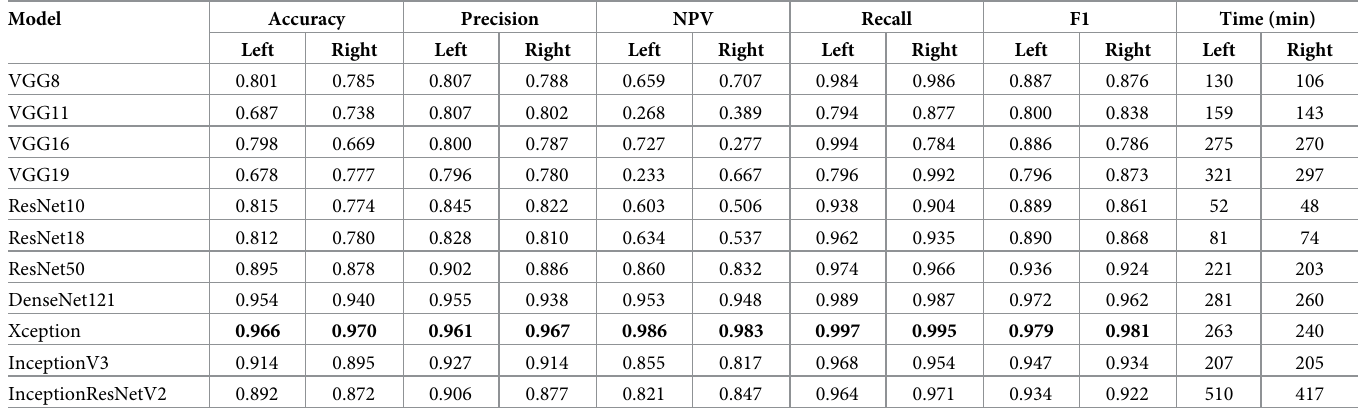
Table 3. Comparison of different CNNs on thyroid cancer diagnosis via CT.